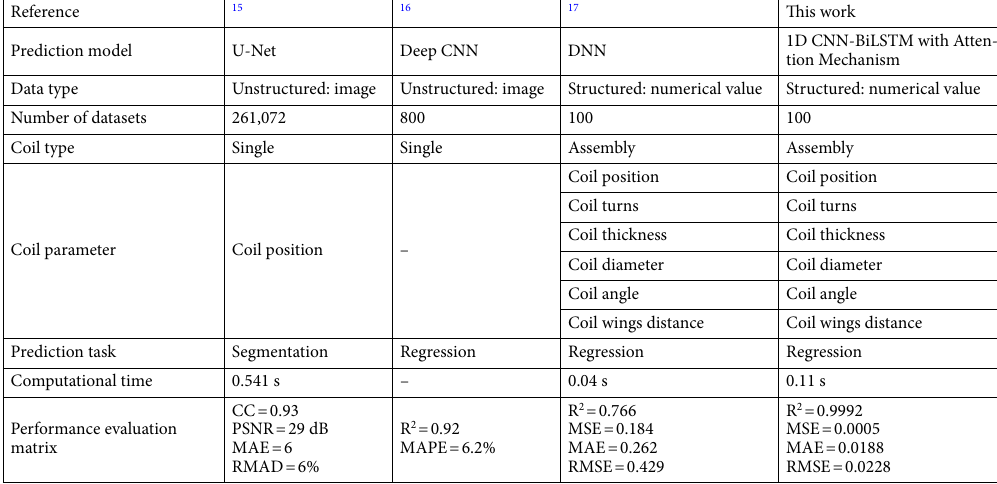
Table 7. Comparison table of the proposed model with the existing related